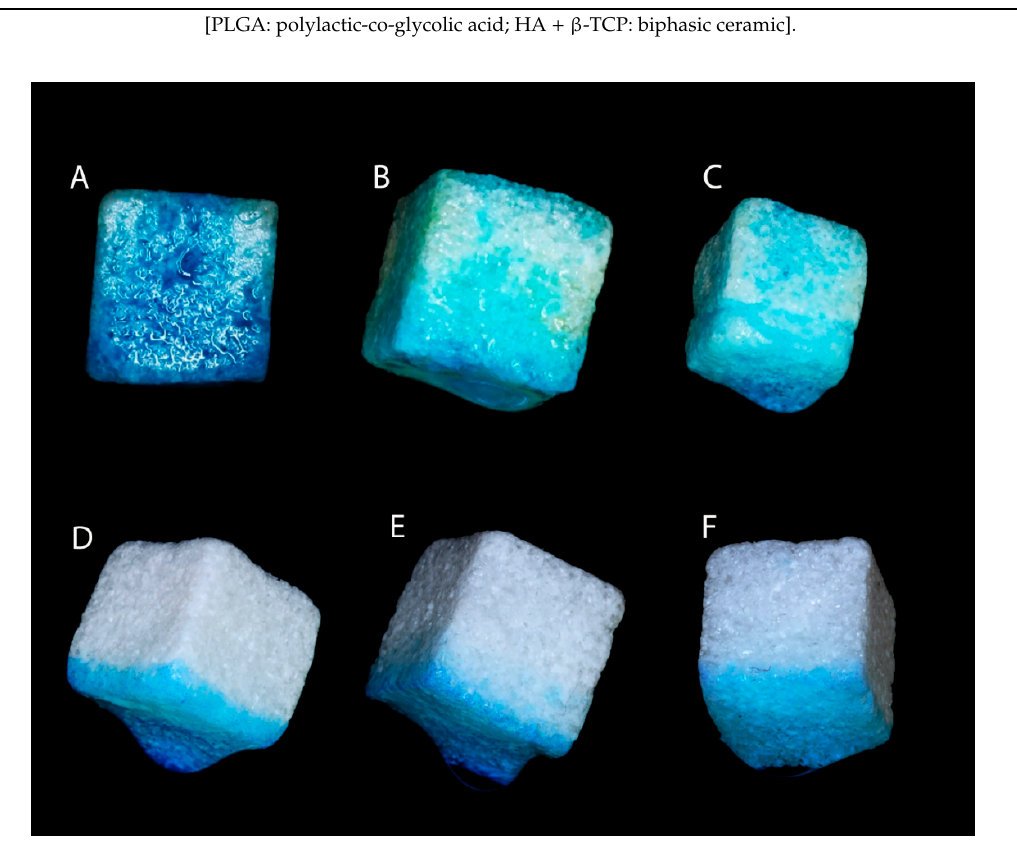
Figure 4. Wettability of the composites made of polylactic-co-glycolic acid (PLGA) and